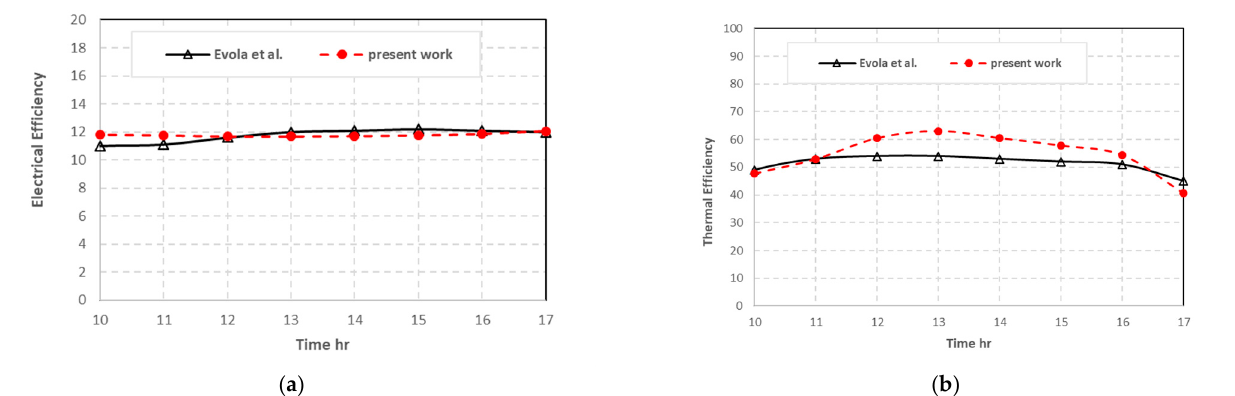
Figure 8. Hourly variations in ( a ) electrical efficiency for present model and [42] ( b ) thermal efficiency for present model and [42].